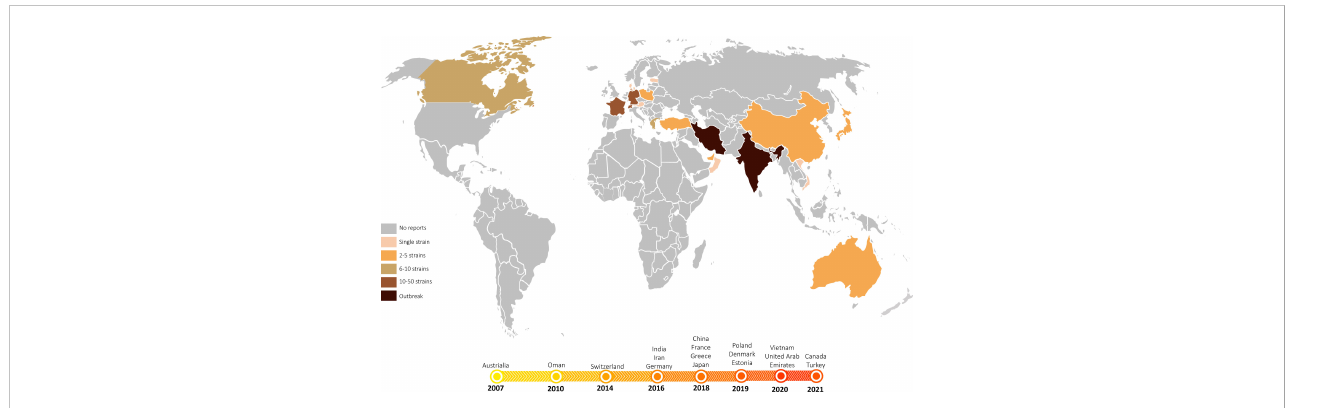
FIGURE 8 The emergence and spread of T. indotineae . World map showing the countries where T. indotineae has been isolated to date. Most countries have detected multiple cases in more than one healthcare institution, with some countries experiencing prolonged outbreaks. In contrast, some countries have so far reported only single cases with no further transmission. The timeline below depicts the years in which T. mentagrophytes type VIII was fi rst isolated in different countries, showing near-simultaneous emergence and spread of T. indotineae across the Indian continent to Europe and the Americas between 2008 and